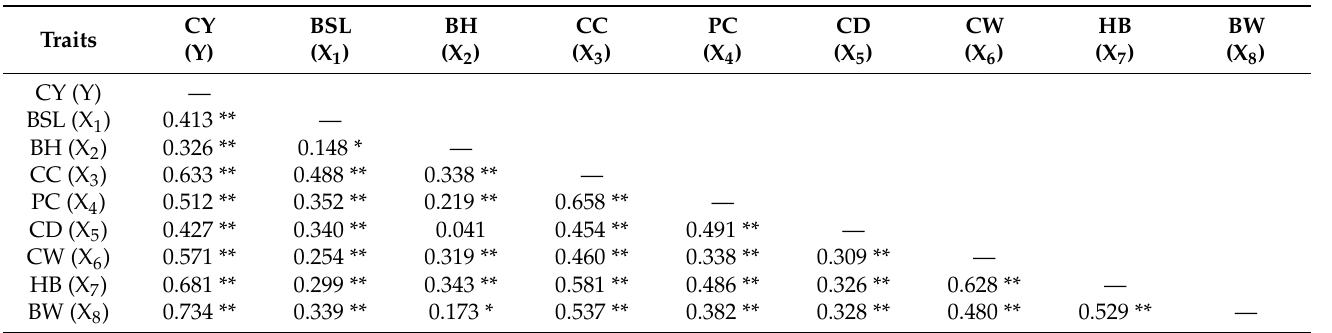
Table 2. Pearson correlation analysis of body measurements between body weight and cashmere yield of Liaoning cashmere goats.